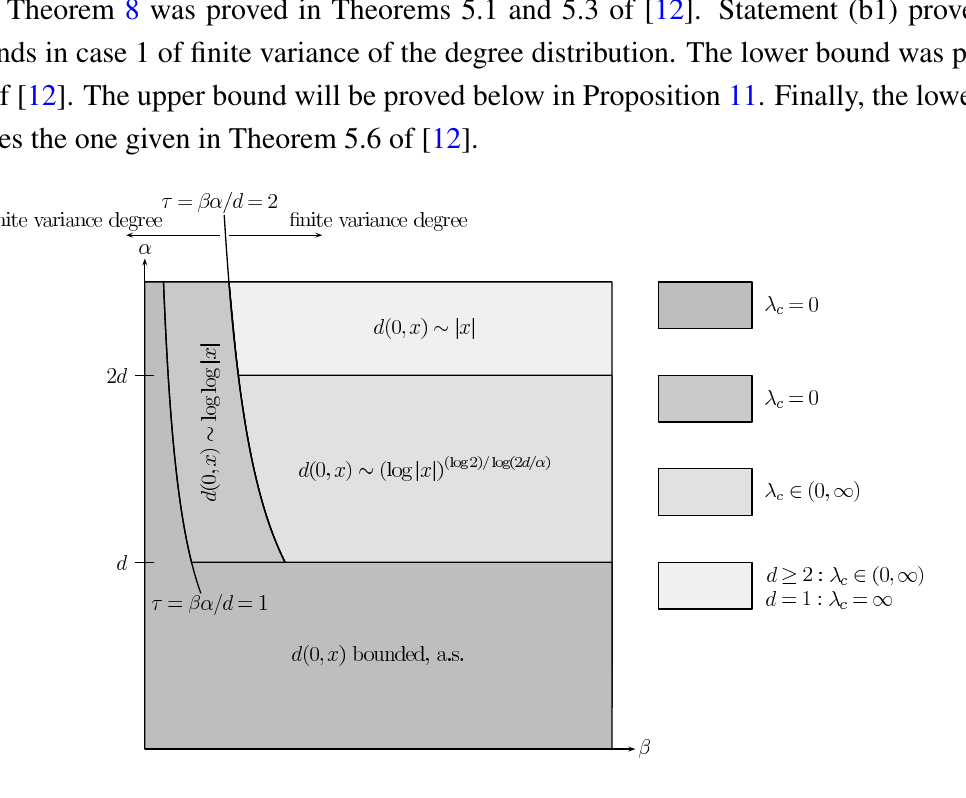
Figure 2. picture about the graph distances (partly as